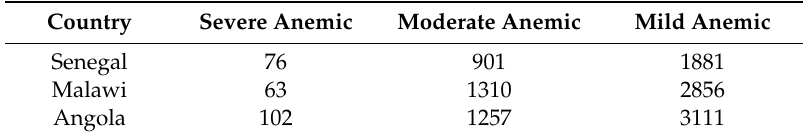
Table 1. Pooled sample size breakdown by country.